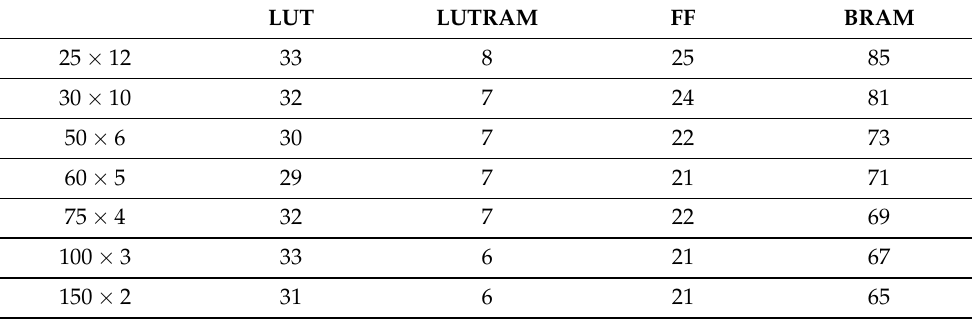
Table 1. Resource